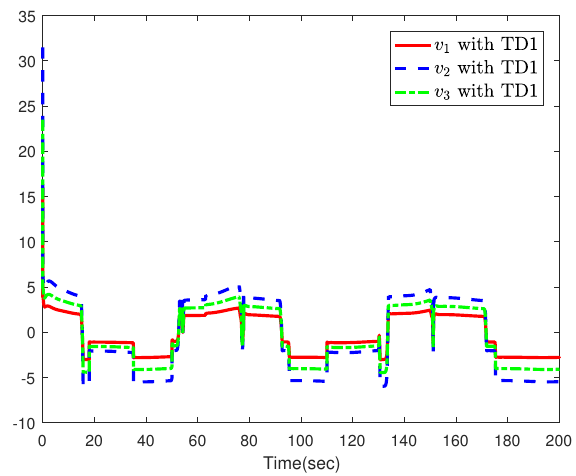
Figure 11. Control effect of System (3) under